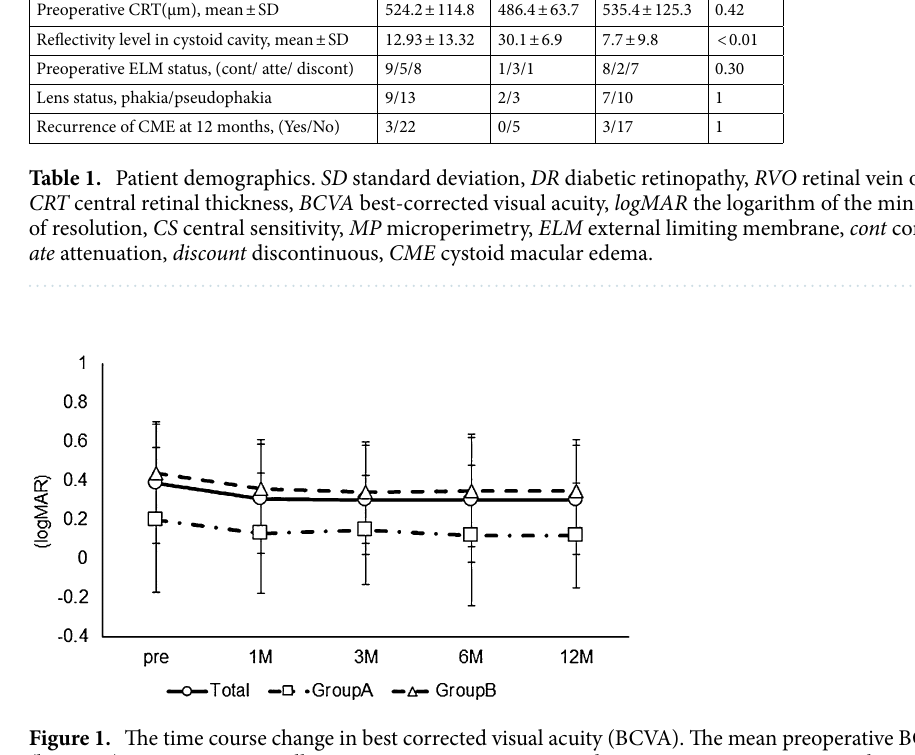
Figure 1. The time course change in best corrected visual acuity (BCVA). The mean preoperative BCVA (logMAR) was 0.39 ± 0.27 in all eyes, 0.20 ± 0.13 in Group A, and 0.44 ± 0.27 in Group B. At each postoperative time point, the BCVA was 0.31 ± 0.27, 0.30 ± 0.27, 0.30 ± 0.29, and 0.30 ± 0.30, respectively, in all eyes, and 0.14 ± 0.12, 0.15 ± 0.13, 0.12 ± 0.12, and 0.12 ± 0.17, respectively, in Group A, and 0.36 ± 0.28, 0.34 ± 0.28, 0.35 ± 0.31, and 0.35 ± 0.31, respectively, in Group B. In all eyes, the BCVA at each postoperative time point was statistically better than the preoperative BCVA (Friedman’s test, p < 0.01; post hoc analysis, p < 0.01 at all